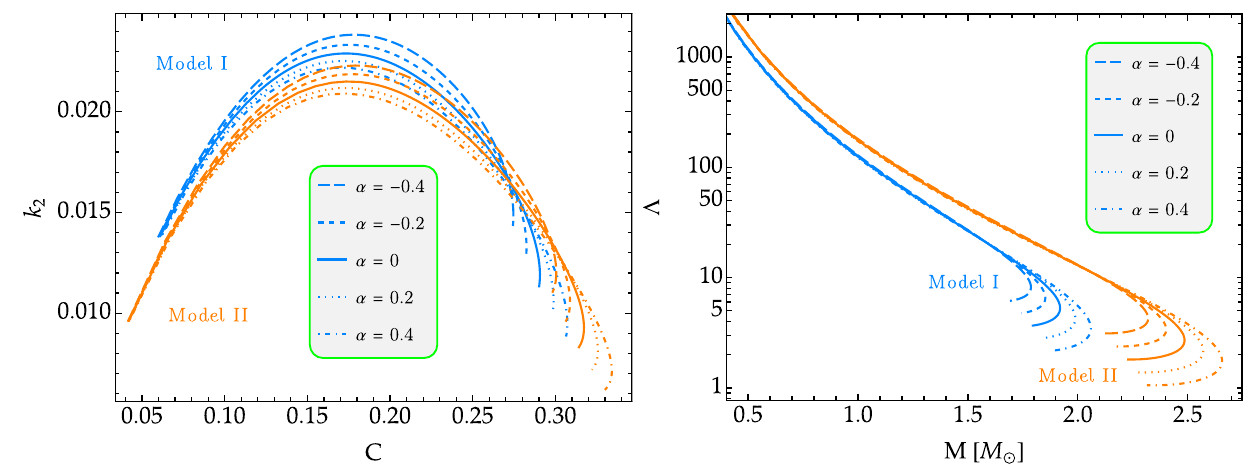
stantiallymodifiedbytheanisotropyparameter α forbothmodels,while its greatest effect on tidal deformability (cid:4) occurs only in the high-mass